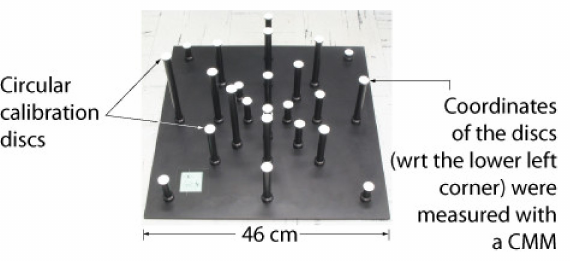
Figure 20. The 3D calibration target used for the stereo experiments. The target is circumscribed in a 500 mm × 500 mm × 250 mm box. The coordinates of the center of the white discs have been measured with a high precision CMM and are used as ground